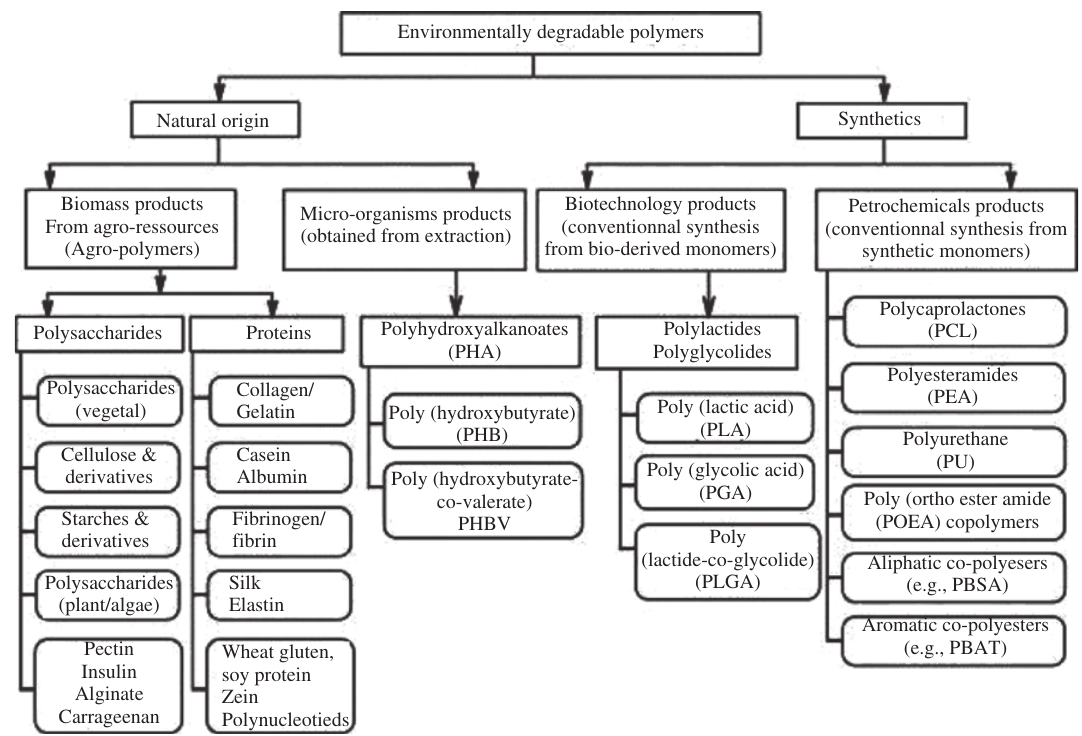
Figure 2: Classifications of the different biodegradable polymers [52]. (© 2015 Elsevier